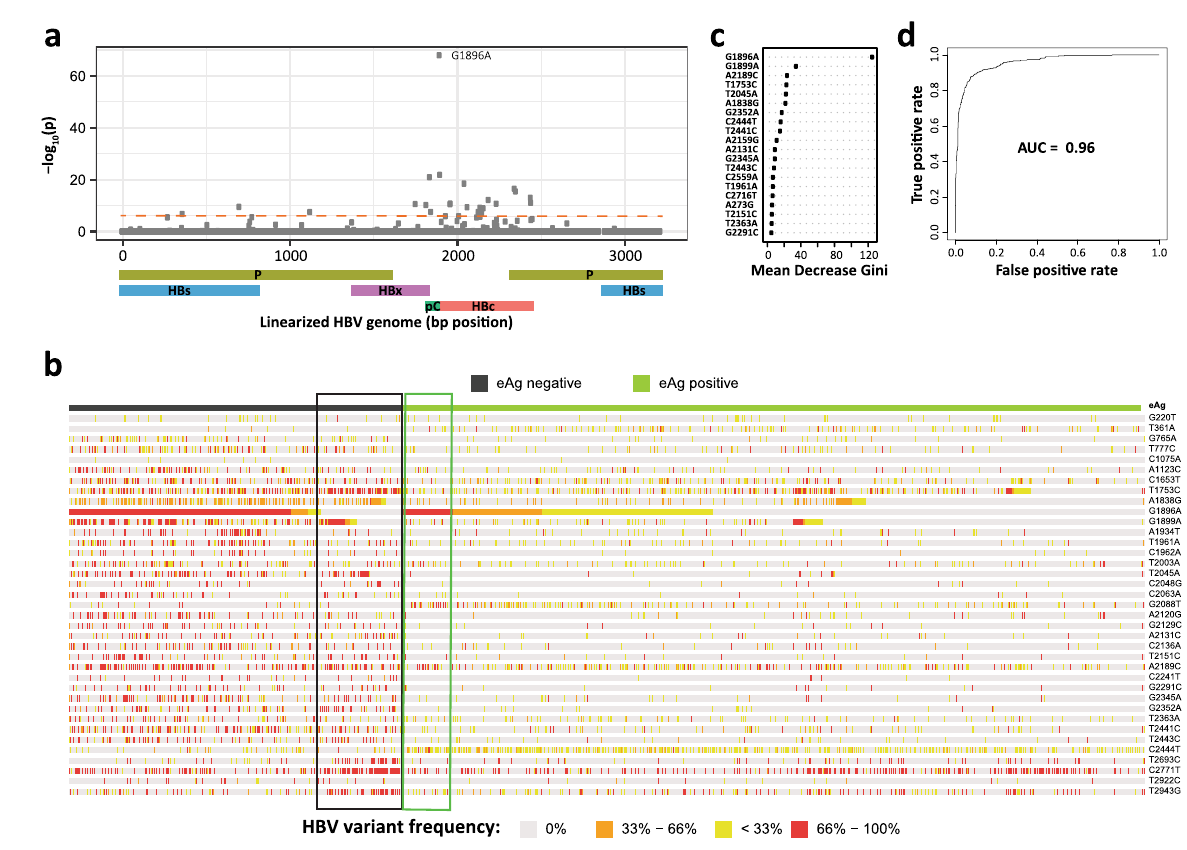
Figure 2. HBV variants associated with patient’s HBeAg status. ( a ) Manhattan plot showing an association (Likelihood Ratio Test p value, see methods) between HBV variants at a given genomic position and patient’s HBeAg status. Bonferroni correction results in a significance threshold of approximately 1.6 × 10 -6 indicated by the red dashed line. See Supplementary Table 3 for a detailed list of variants associated with HBeAg status. Schematic below x axis represents HBV genome structure. P – polymerase, S – surface protein, C – core protein, pC – pre- core region, X – HBx protein. ( b ) Heatmap of HBV variants associated with HBeAg status and detected across 1102 patients of the discovery cohort. The 37 variants selected for classification modeling are displayed. The top row indicates patient’s HBeAg status. Columns (patients, N = 1102) are ordered by HBeAg status and by G1896A frequency. Rows (HBV variants) are ordered given variant’s genome position. Black box highlights HBeAg negative patients without detectable viral G1896A variant. The green box highlights HBeAg positive patients with a high frequency of viral G1896A variant. ( c ) Mean decrease in Gini index, reflecting a relative importance of a variant within a HBeAg status classifier model, is shown for top 20 variants. See Supplementary Table 3 for a detailed list of variants used in the model and their mean decrease in Gini index. ( d ) ROC and AUC from random forest model classifying patient’s HBeAg status within the discovery patient cohort (N =